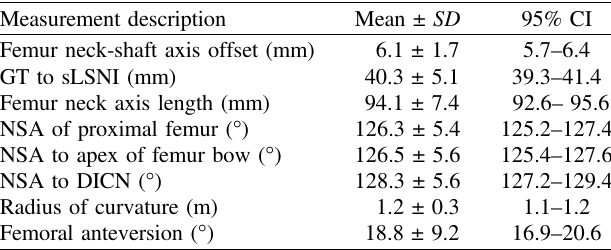
Table 1. Measurement data of the